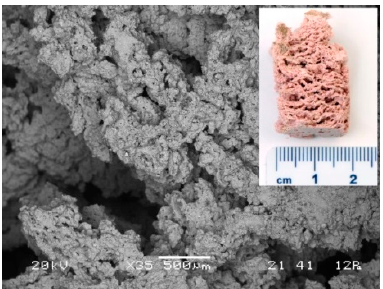
Figure 14. SEM micrograph of AAF prepared with 25 g of mixture ζ 0 , 50 g of precursor, 10% of H 2 O 2 , 0.1% of Na-dodecyl sulphate. On the micrograph’s inset is photography of cross-cut sample.